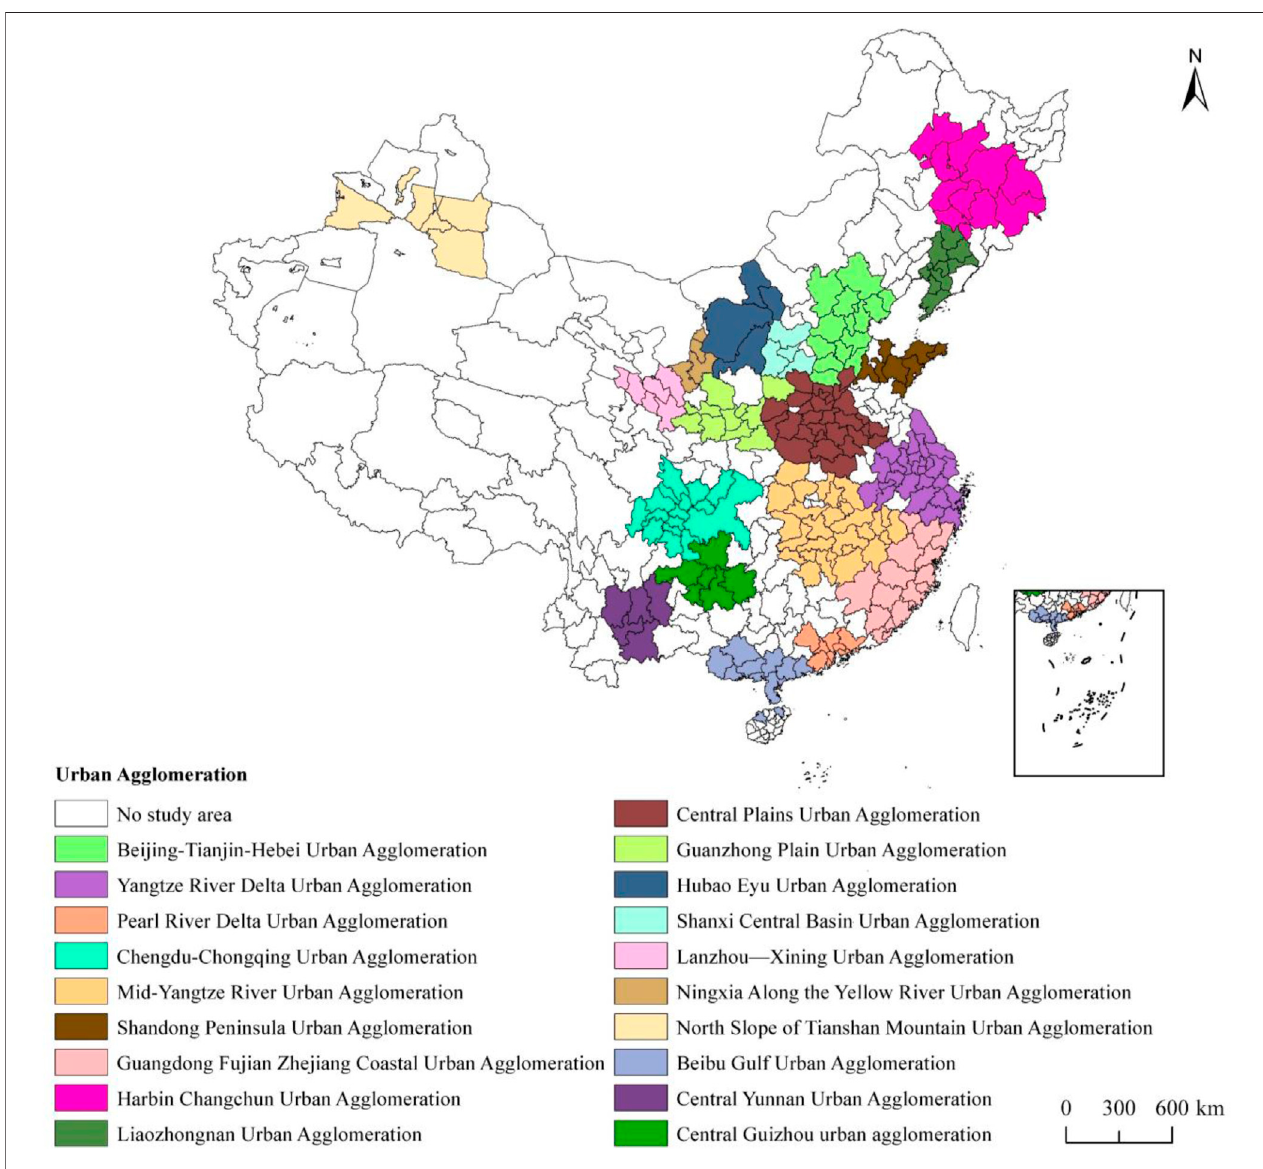
FIGURE 2 | Spatial distribution of cities in existing urban agglomerations in